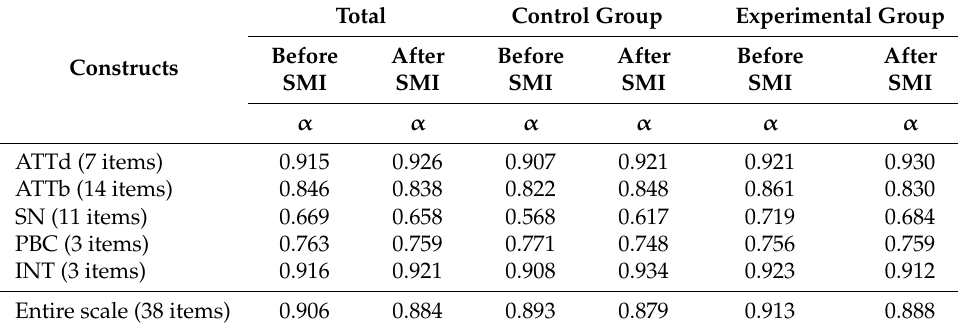
Table 2. Internal consistency of the measures (Cronbach